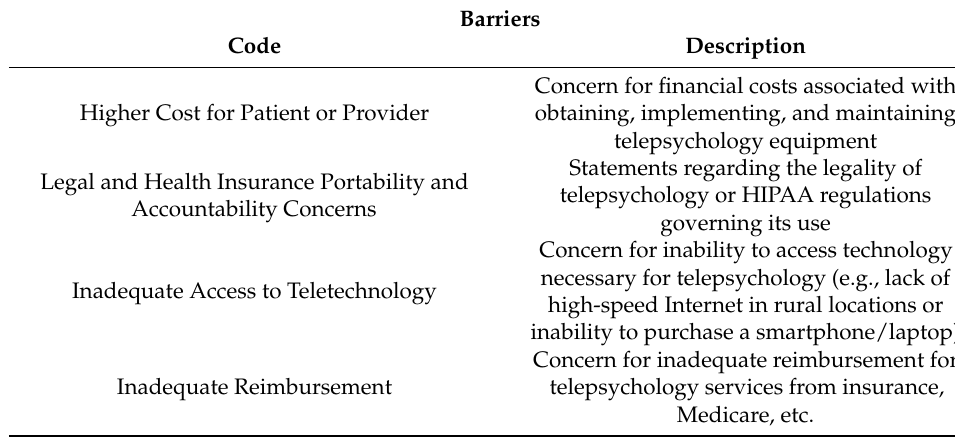
Table 2. Final List of Barriers and